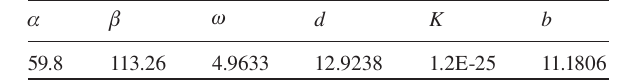
G1/Ep laminate [15] . S